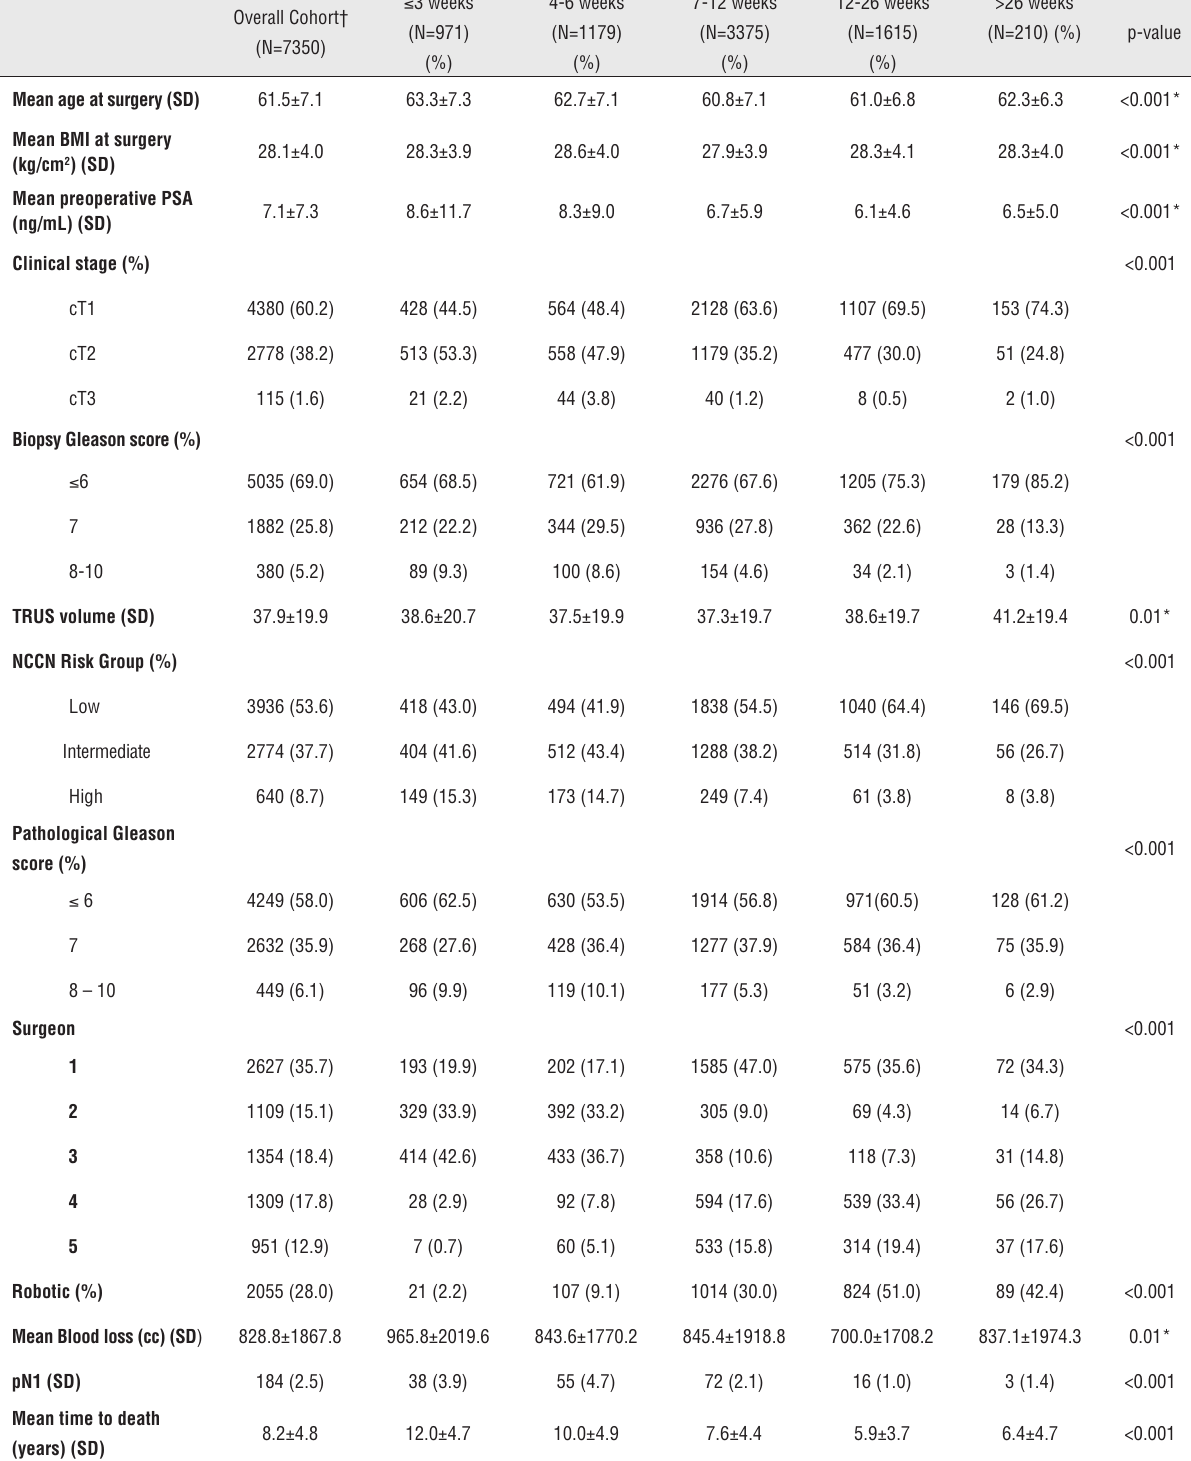
Table 1 - Clinicopathologic Characteristics stratified by time from biopsy to